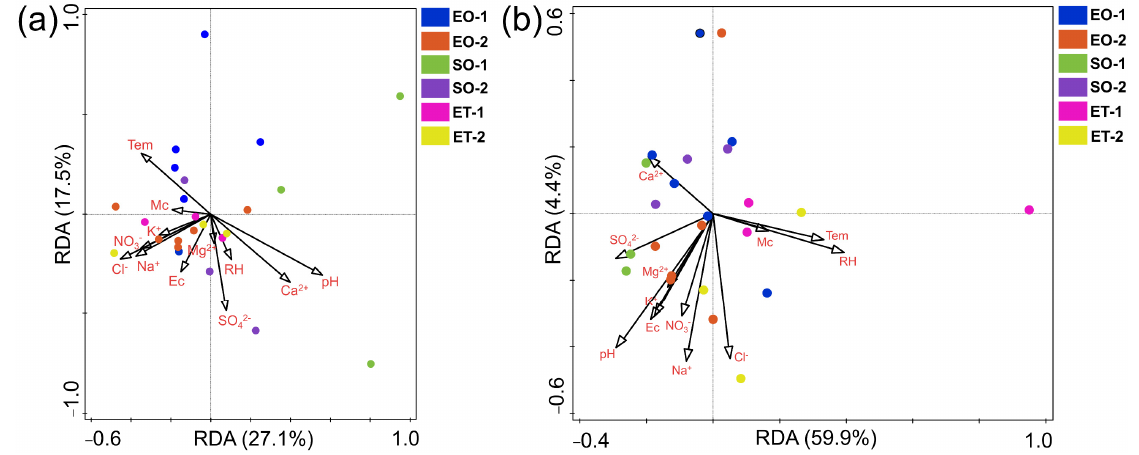
Figure 6. Redundancy analysis of bacterial ( a ) and fungal ( b ) communities and environmental parameters from the different sites.